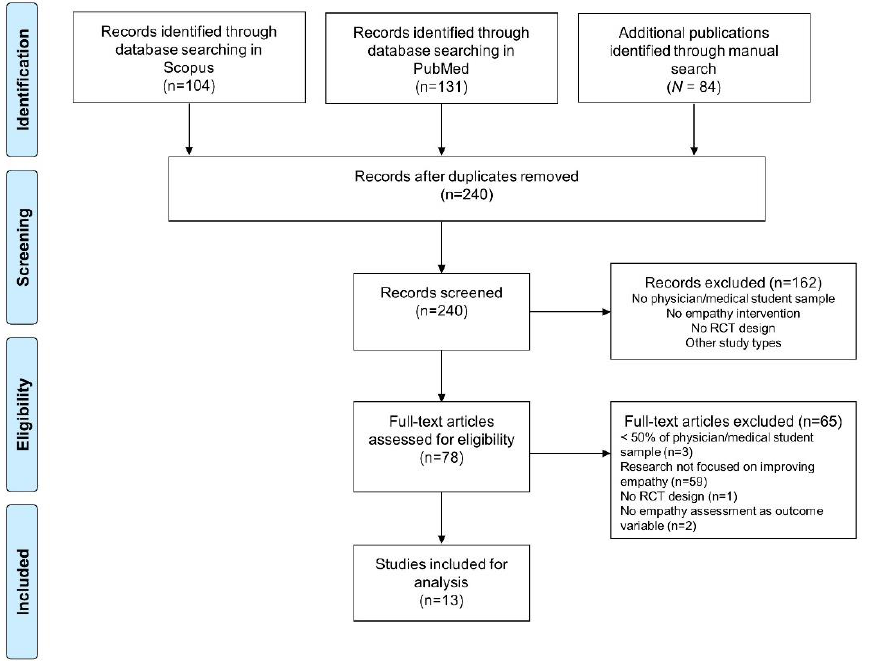
Figure 1. Flow chart of the search process.